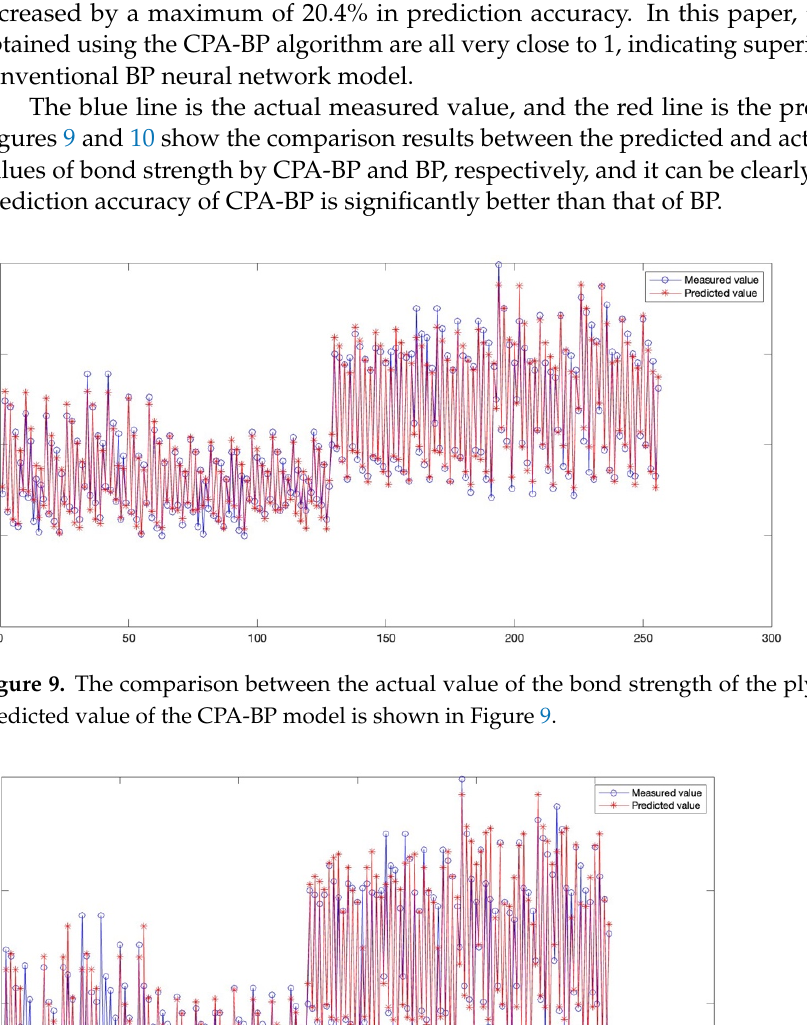
( b ) Figure 8. ( a , b ) are two graphs showing the relationship between the training set, the validation set, and the test set predicted value and the actual value when the BP and CPA-BP model predicts the surface roughness (Rmax) of plywood.